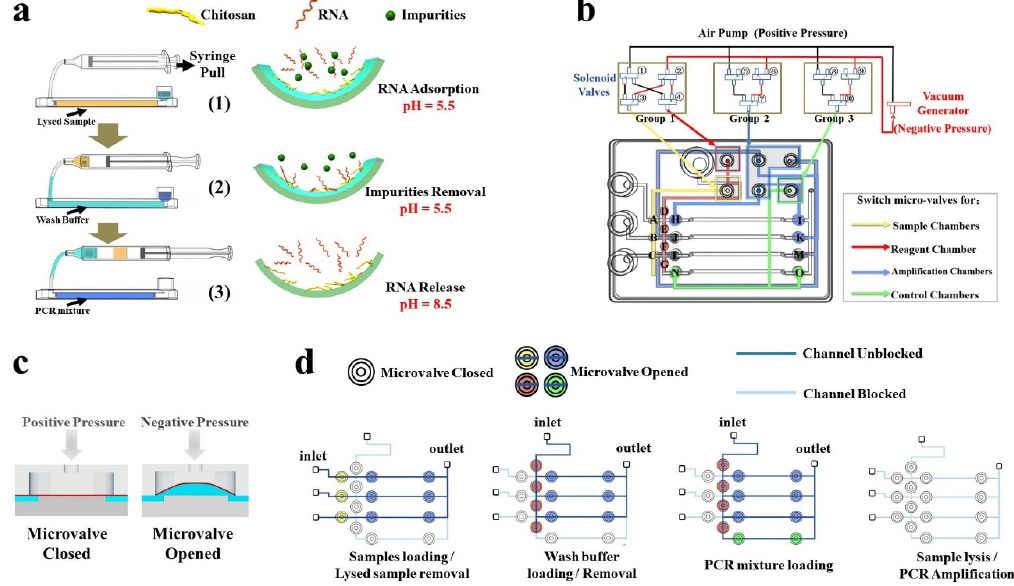
Figure 3. Working principle of the chip. ( a ) Illustration of individual sample process by a single capillary chamber based on charge-switch ability of chitosan, corresponding to lysed sample, wash bu ff er and PCR mixture were loaded into a capillary chamber by a unidirectionally moving piston. The target nucleic acids were adsorbed in the acidic solution (pH 5.5) and desorbed into PCR mixture in alkaline solution (pH 8.5). ( b ) The distribution diagram of liquid flow channels (uncolored channels), air flow channels (colored channels), microvalves (lettered) on the chip and corresponding solenoid valves (numbered). ( c ) The figure of the microvalves. The deformation of the membrane in the microvalve was a ff ected by the air pressure to control the blocking and unblocking of the corresponding channel. ( d ) The schematic diagram of the four working states of the microvalve on the microfluidic chip, respectively are: samples loading and lysed samples removal, wash bu ff er loading or removal, PCR mixture loading, sample lysis or PCR